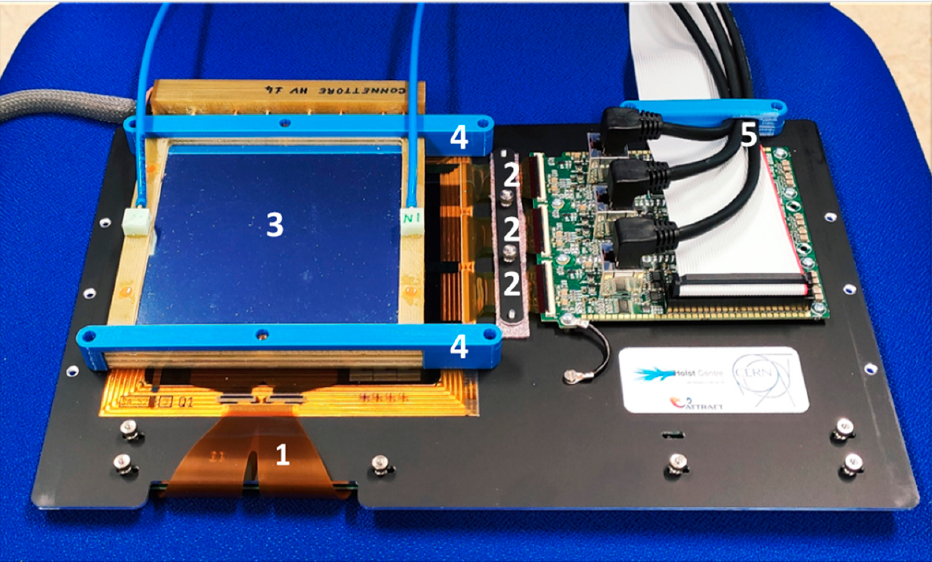
Figure 2. The first LaGEMPix prototype: ( 1 ) flex gate driver integrated circuit; ( 2 ) flex Read-out Integrated Circuits (ROICs); ( 3 ) the triple-GEM 100 × 100 mm 2 stack coupled to the optical readout with the thin Mylar window on top; ( 4 ) 3D-printed braces to hold together the triple-GEM detector and the image sensor; and ( 5 ) cables to connect the detector to the readout system.